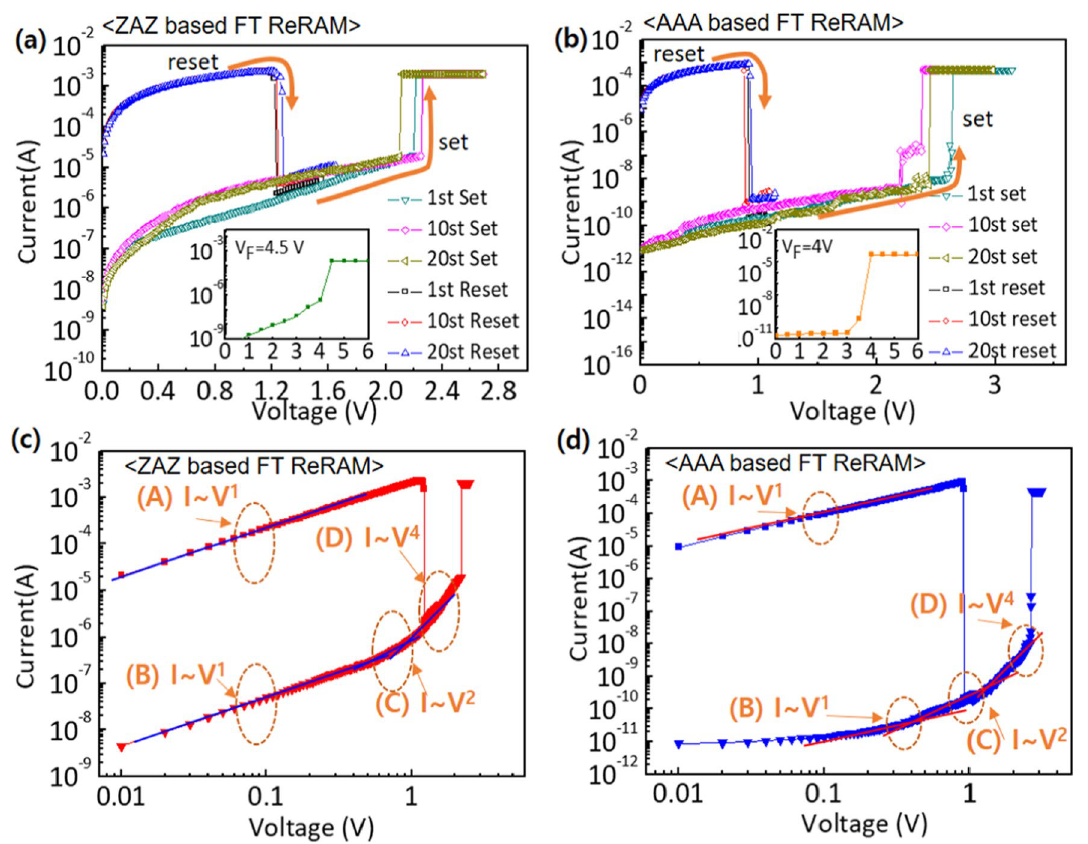
Fig. 19 I–V current characteristics showing the forming process of a ZnO/Ag/ZnO device (ZAZ) and b crossly stacked layers of Al 2 O 3 /Ag/Al 2 O 3 (AAA). The logarithmic plots of the I–V characteristics of c ZAZ device d AAA stacked layers device. These unipolar I–V characteristics of the devices show that flexibility or transparency does not hinder the operational characteristics of WMC devices